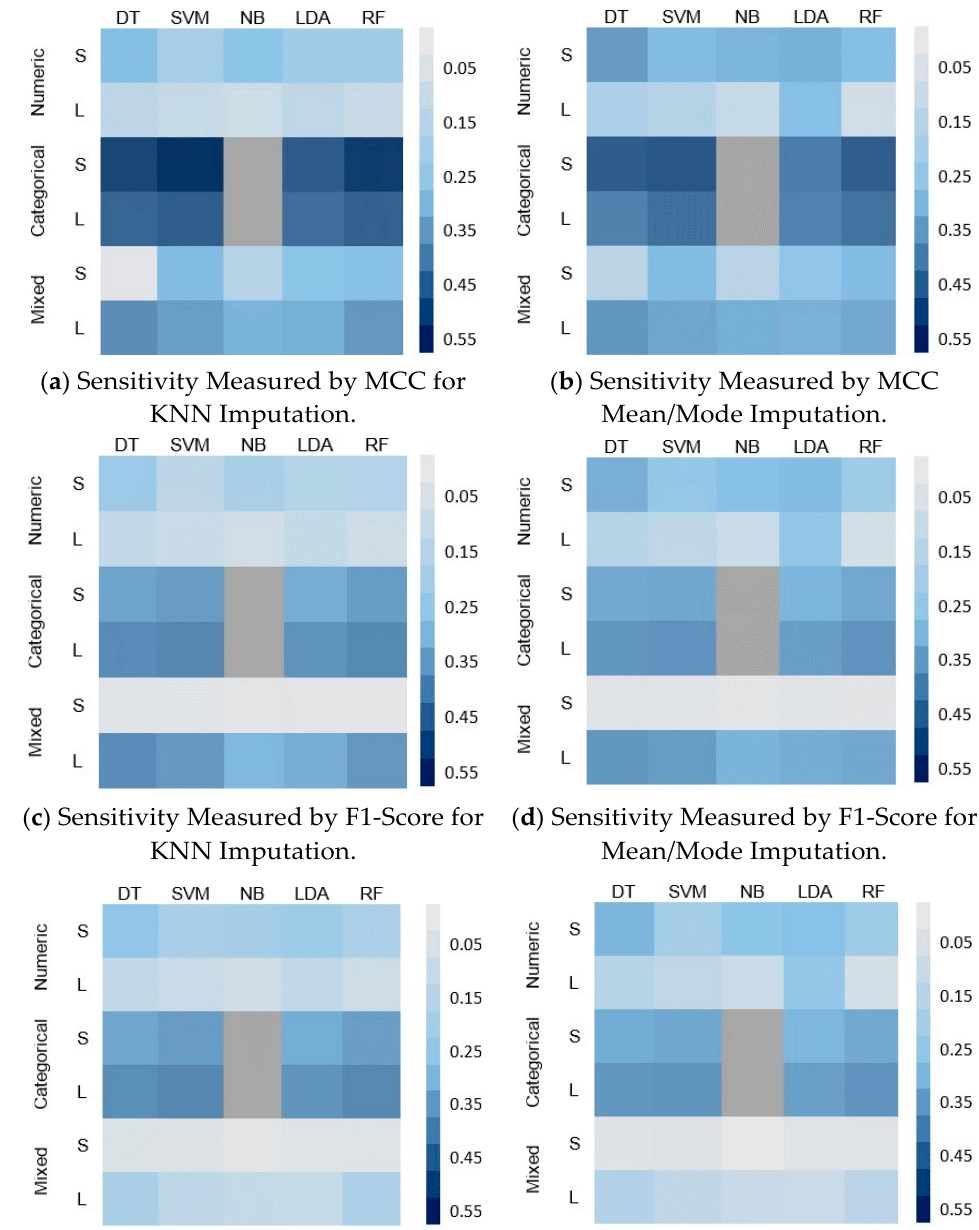
Figure 6. Classifier sensitivity of the five classifiers on different sizes and types of dataset with MCAR MVs.